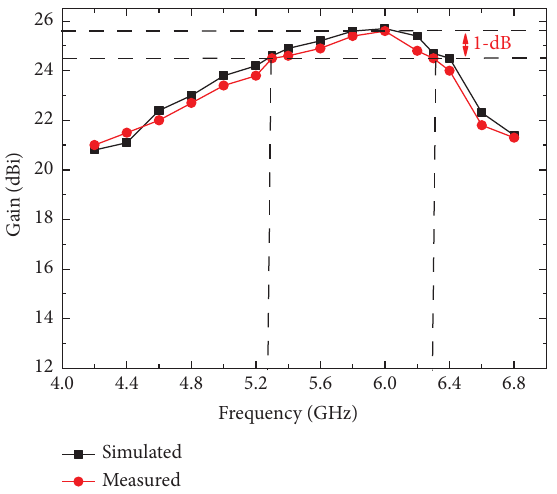
Figure 19: Gain versus frequency